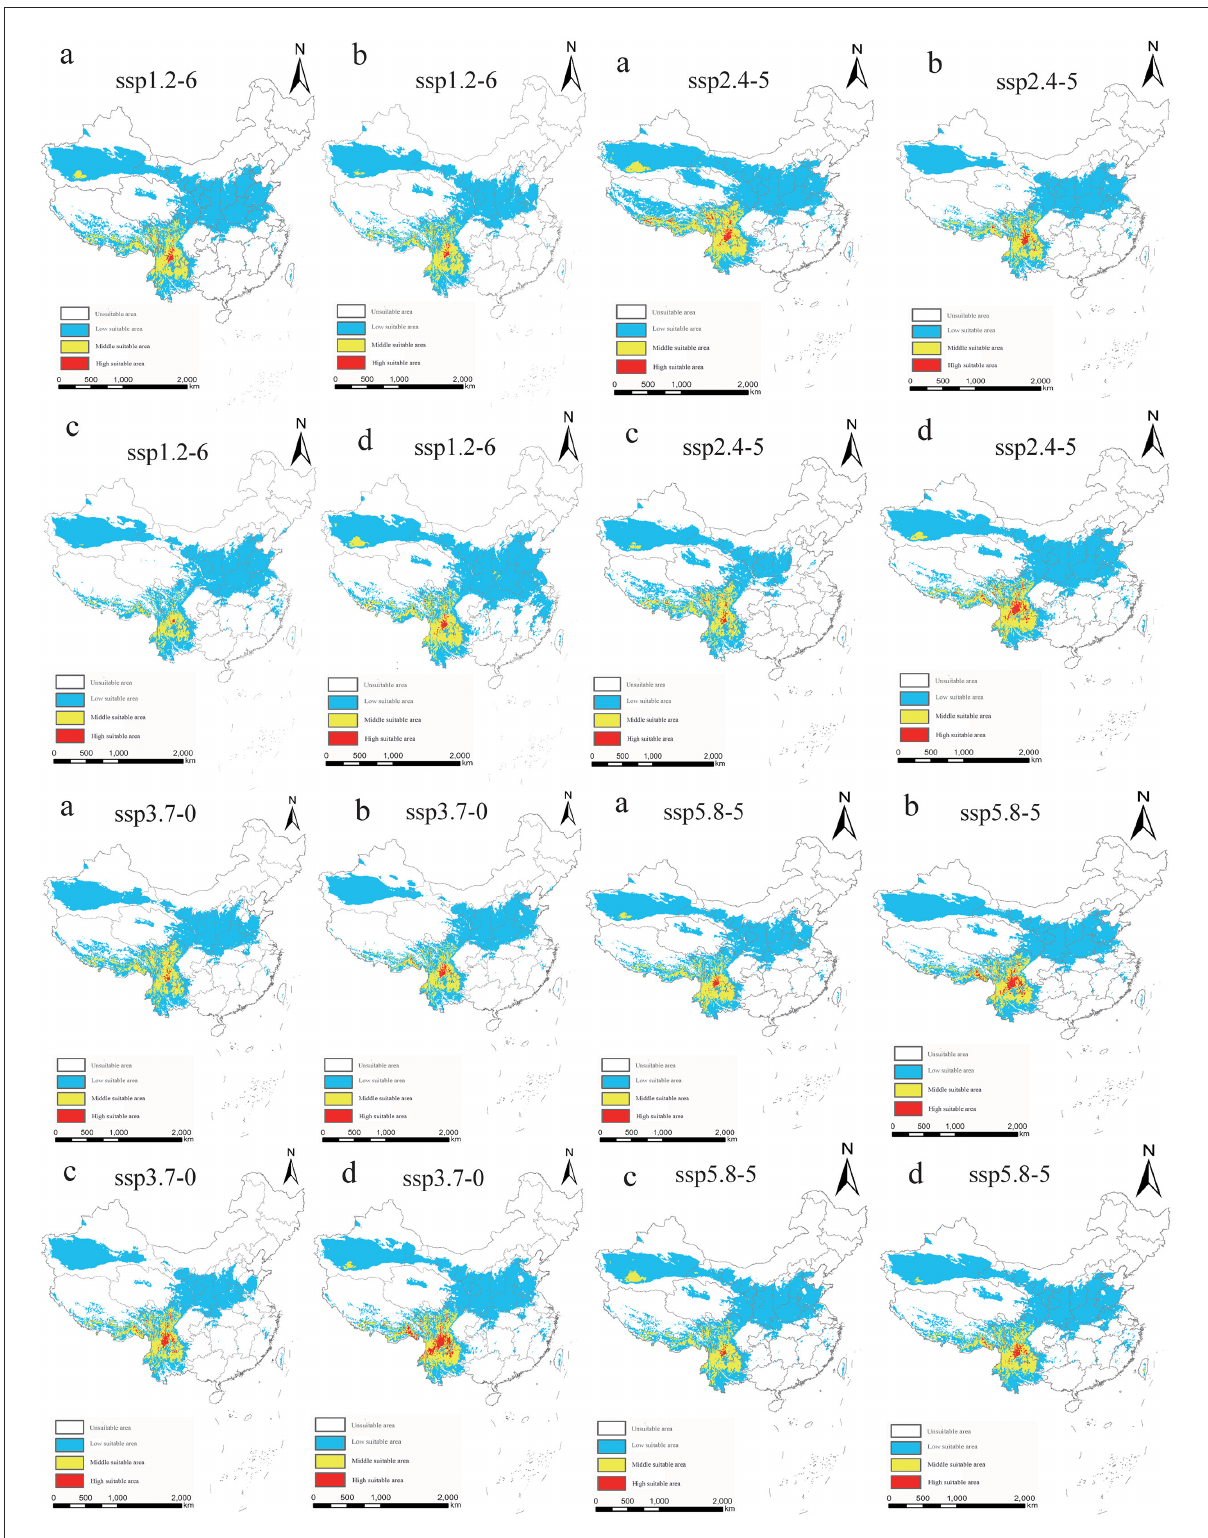
FIGURE5 Suitable areas in China for P. hesperomys under different future climate scenario models (a: 2021–2040, b: 2041–2060, c: 2061–2080, and d: